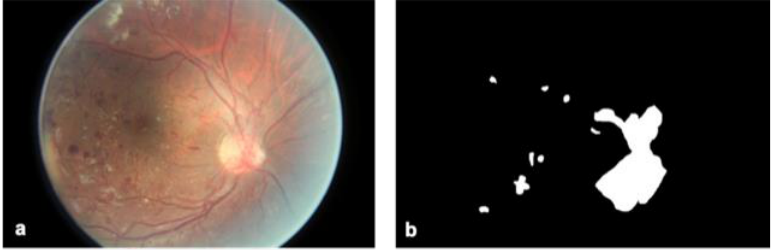
Figure 1. NV mask example. A retinal photograph ( a ) is shown with the NV mask created for it by the research team ( b ). White pixels in the mask ( b ) indicate areas of active NV or severe IRMA. Black pixels indicate areas without NV. This example shows NV clustering around the optic nerve.